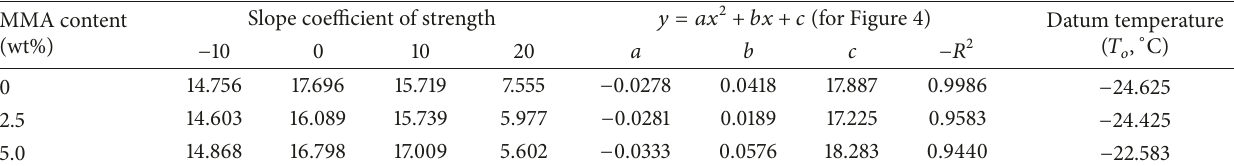
Table 11: Calculation results of datum temperature.